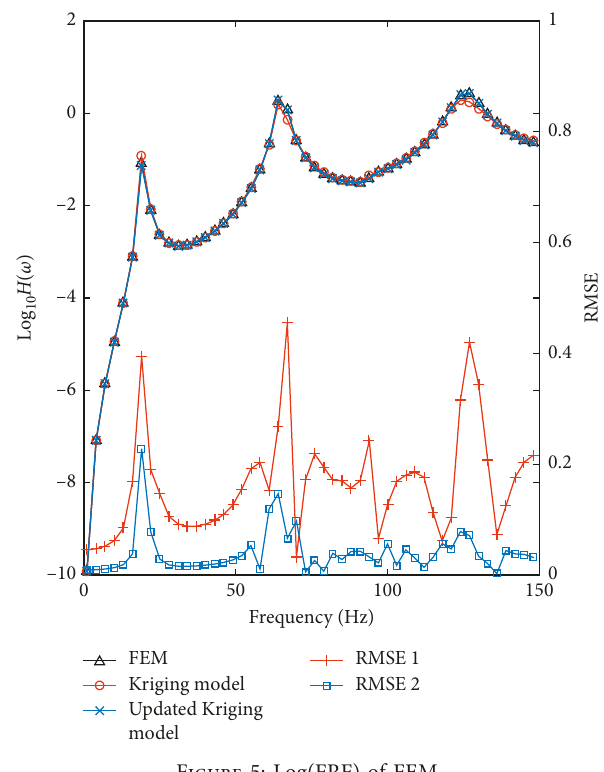
Figure 5: Log(FRF) of